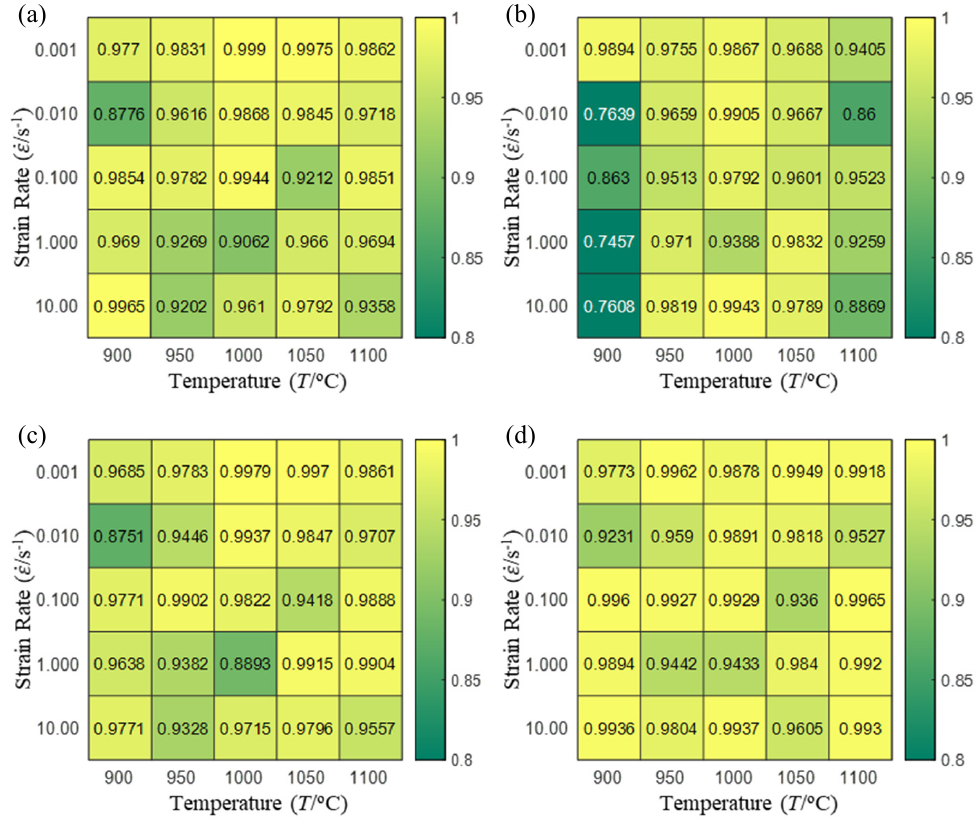
Figure 12. The distribution of the correlation coefficient between predicted flow stress and experimental flow stress on temperature and strain rate: ( a ) Arrhenius model; ( b ) HS model; ( c ) linear model; ( d ) quadratic model.